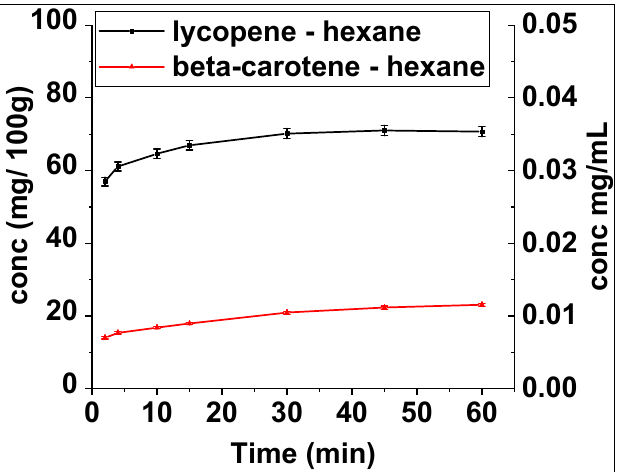
Figure 3. Change in lycopene and beta-carotene concentration (mg carotenoid/100 g dry plant (left y-axis) and mg carotenoid/mL solvent (right y-axis)) during extraction from Pontica 102 skins with hexane, under conventional conditions at 60 °C.